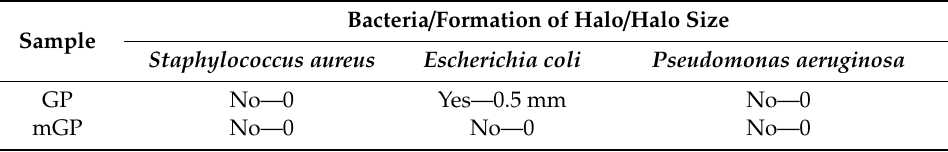
Table 4. Results of the first bactericidal test phase: standardization